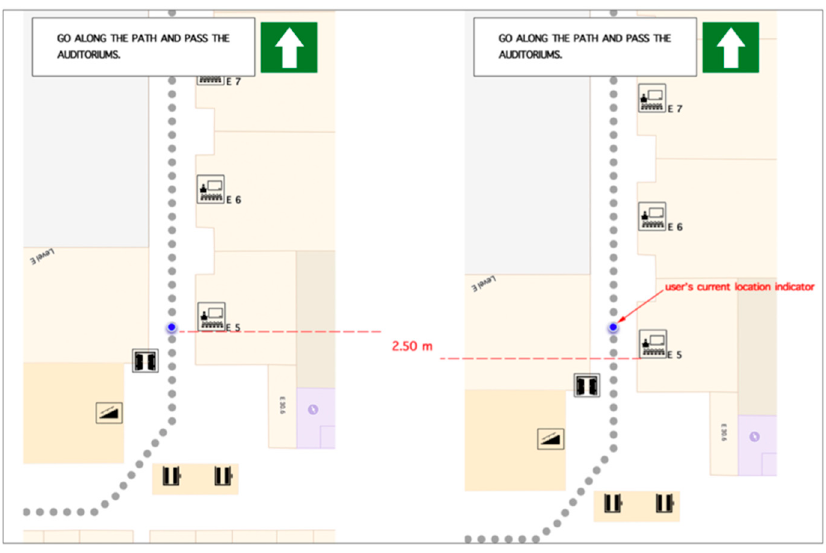
Figure 7. Successive images along the routing path (from left to right). Multimodal Technol. Interact. 2019 , 2 , x FOR PEER REVIEW